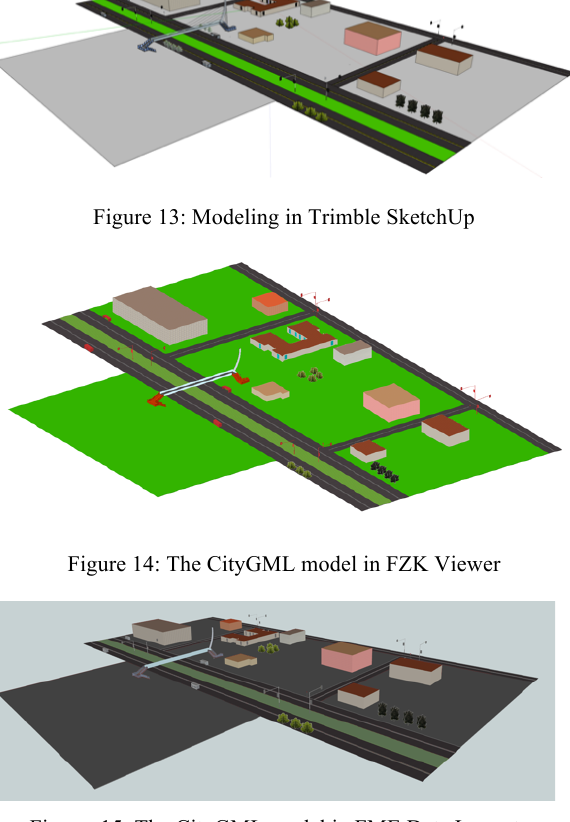
Figure: 15: The CityGML model in FME Data